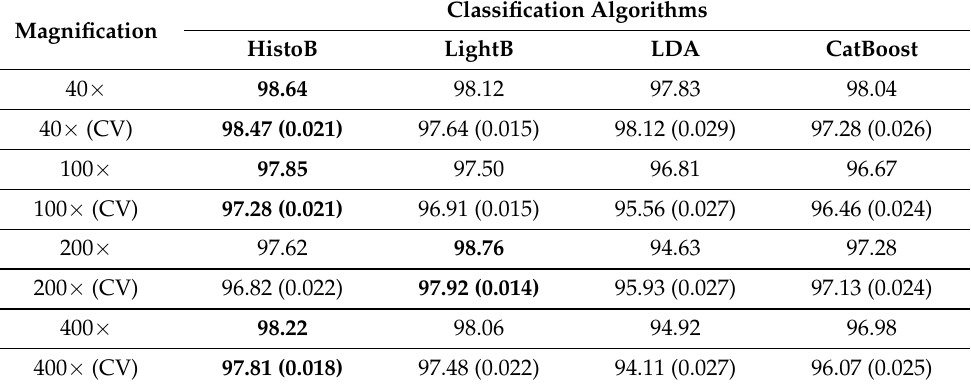
Table 8. Image-level accuracy (%) of monolithic classifiers and ensemble methods with the TiO descriptor on 8 balanced classes of the BreakHis dataset. The best result for each magnification is shown in boldface. CV denotes the average accuracy and standard deviation (%) using a 10-fold cross-validation experimental